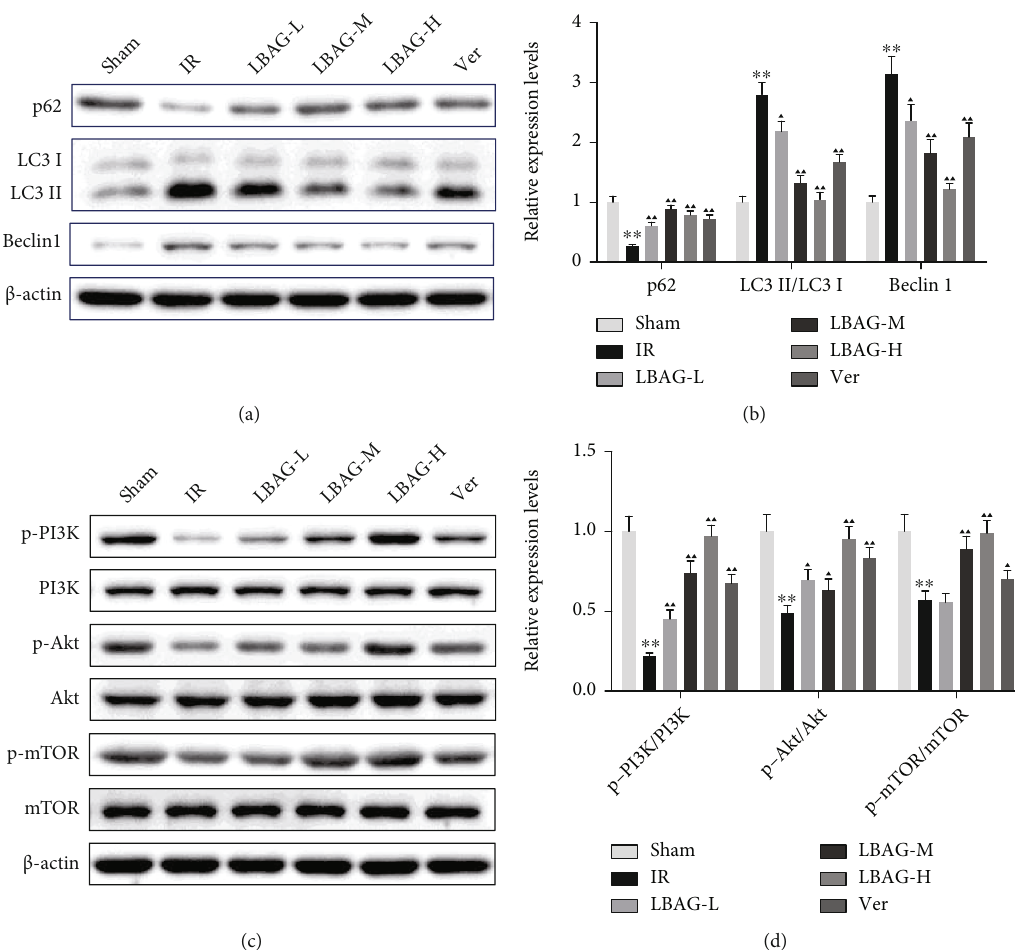
Figure 5: E ff ect of LBAG on the expression of autophagy and PI3K/AKT pathway-related proteins in rats. (a) Representative protein blots of p62, LC3, and Beclin 1. (b) Quantitative analysis of p62, LC3, and Beclin 1 proteins. (c) Representative protein blots of PI3K/AKT pathway-related proteins. (d) Quantitative analysis of PI3K pathway-related targets in each group. ∗ P < 0 : 05 and ∗∗ P < 0 : 01 vs. sham group. ▲ P < 0 : 05 and ▲▲ P < 0 : 01 vs. IR